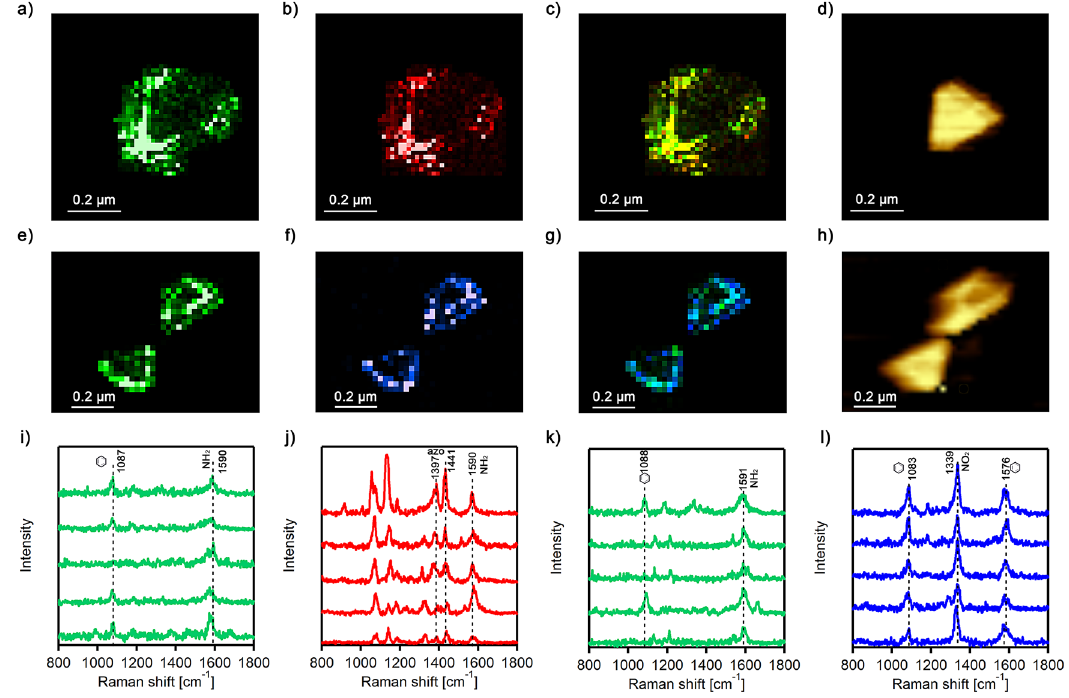
Figure 9: Photo oxidation of 4-ATP to DMAB and 4-NBT. (a) TERS image of 4-ATP and (b) DMAB, as well as (c) TERS image of AuNPs with both NO 2 and N=N vibrations; (d) corresponding AFM image of AuNPs; (e) TERS image of 4-ATP on Au@PtNPs; (f) TERS image of 4-NBT on Au@PtNPs; (g) TERS image of Au@PtNPs from overlapping NH 2 and NO 2 vibrations. Intensity of 1590 cm − 1 band (NH 2 vibration) of 4-ATP is shown in green; intensity of 1339 cm − 1 band (NO 2 vibration) of 4-NBT